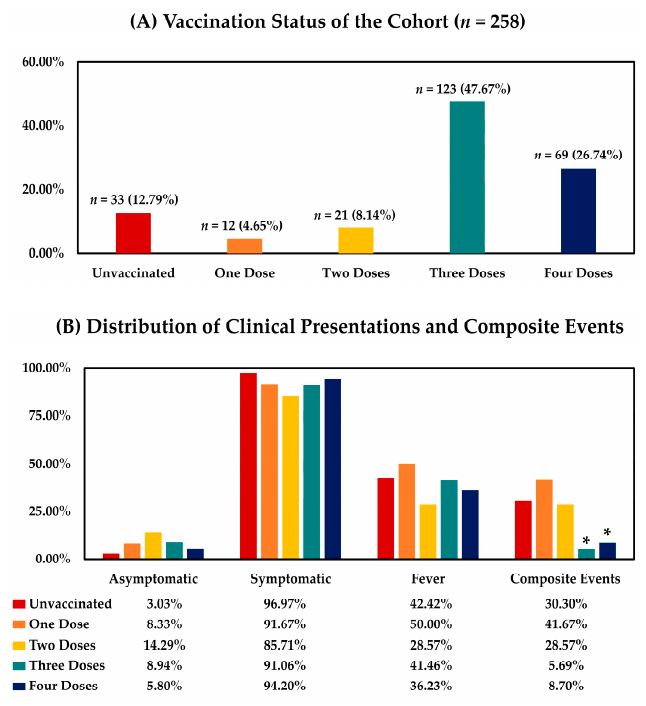
Figure 2. Vaccination Status, Presentations, and Composite Events of the Enrolled HD Patients. ( A ). Vaccination status of the cohort ( n = 258); ( B ). distribution of clinical presentations and composite events. The composite events were defined as COVID-19-related acute care visits, hospitalizations, or mortality events within 30 days after disease onset. *: p < 0.05 compared with unvaccinated patients and those who received one or two doses of vaccination.